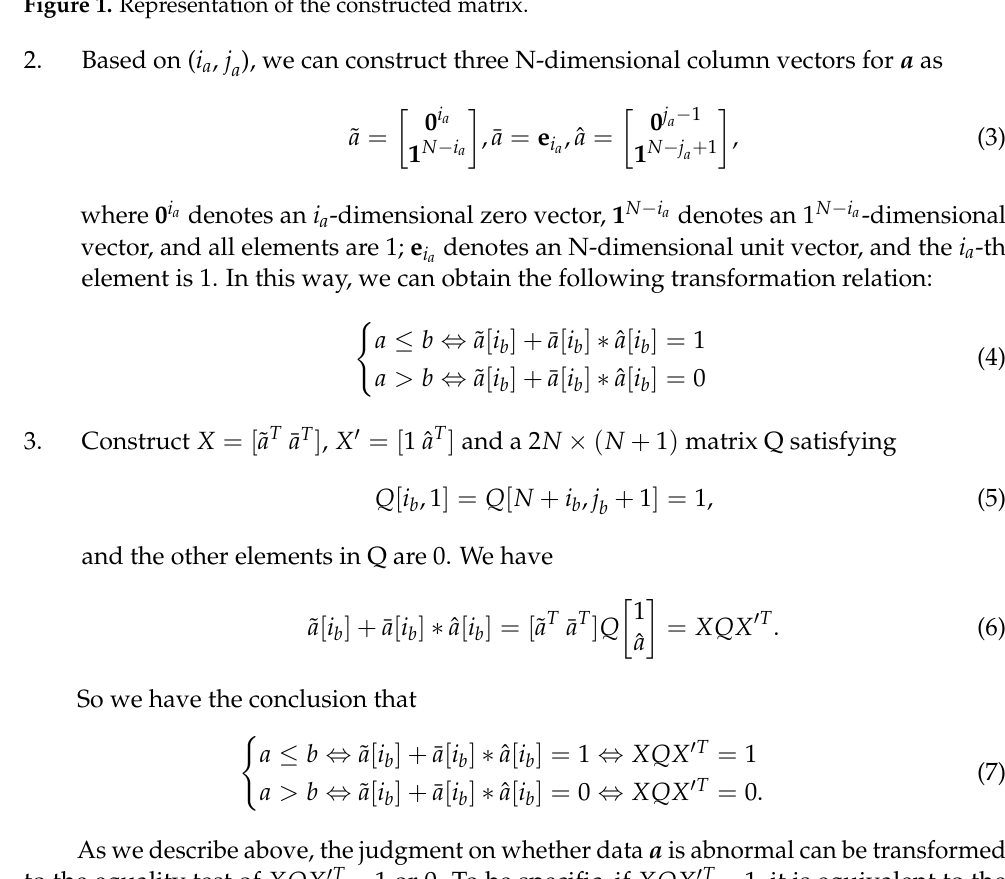
Figure 1. Representation of the constructed